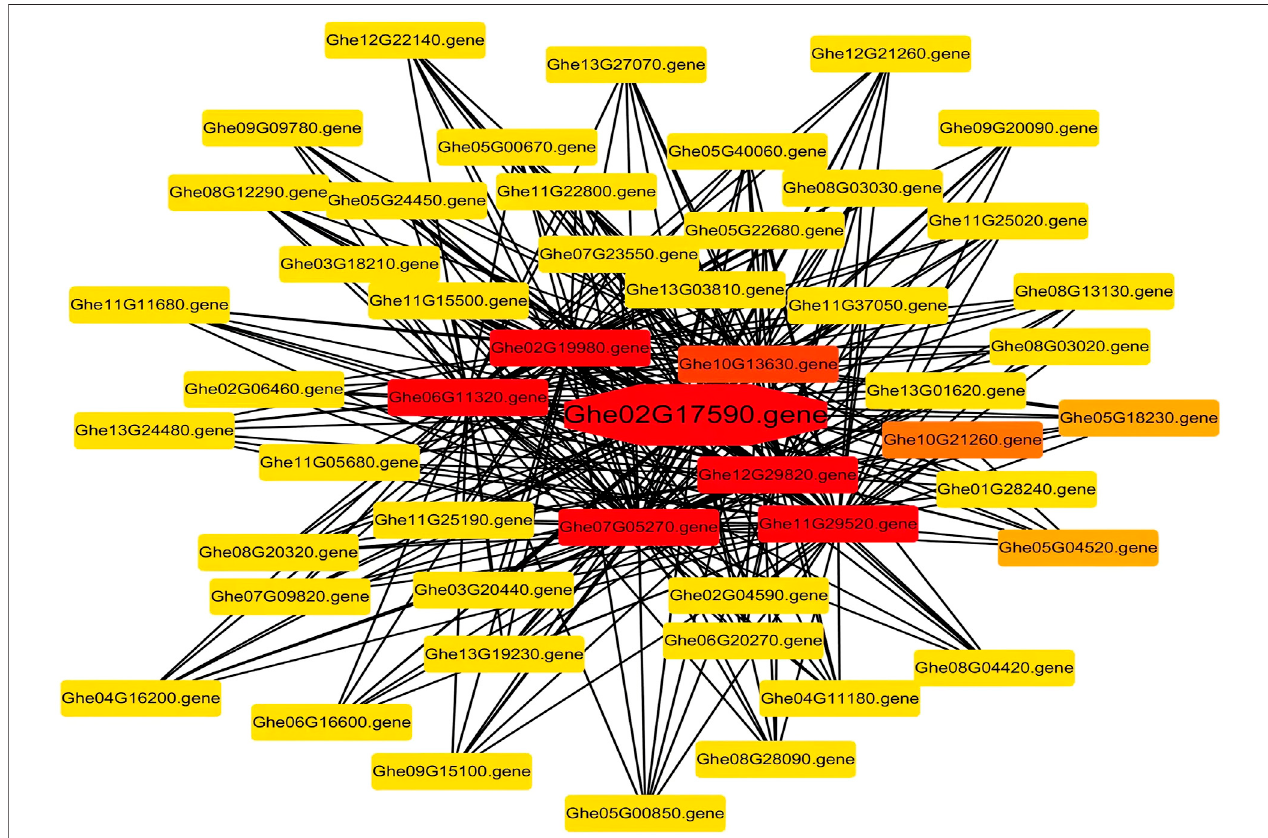
FIGURE8| ThePearsoncorrelationnetworkanalysis.Co-expressionnetworkofDEGs.Thegeneinthecenterofthenetworkwithredcolorandoctagonalshapeis represented as a hub gene.